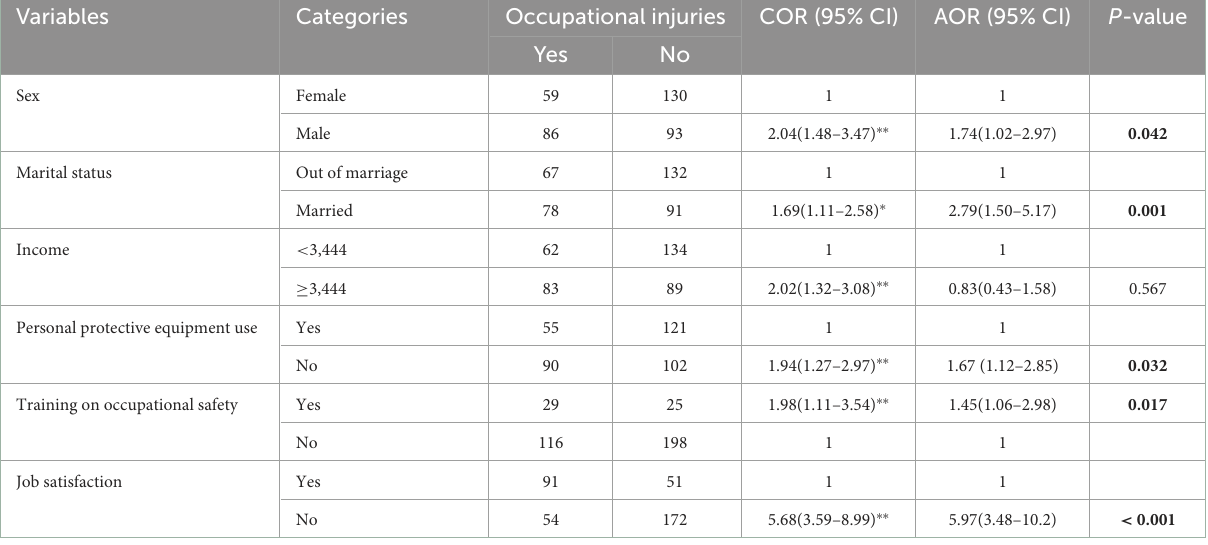
TABLE 3 Common occupational and behavioral factors of injuries among Bure industry park construction workers in Northwest Ethiopia. Variables